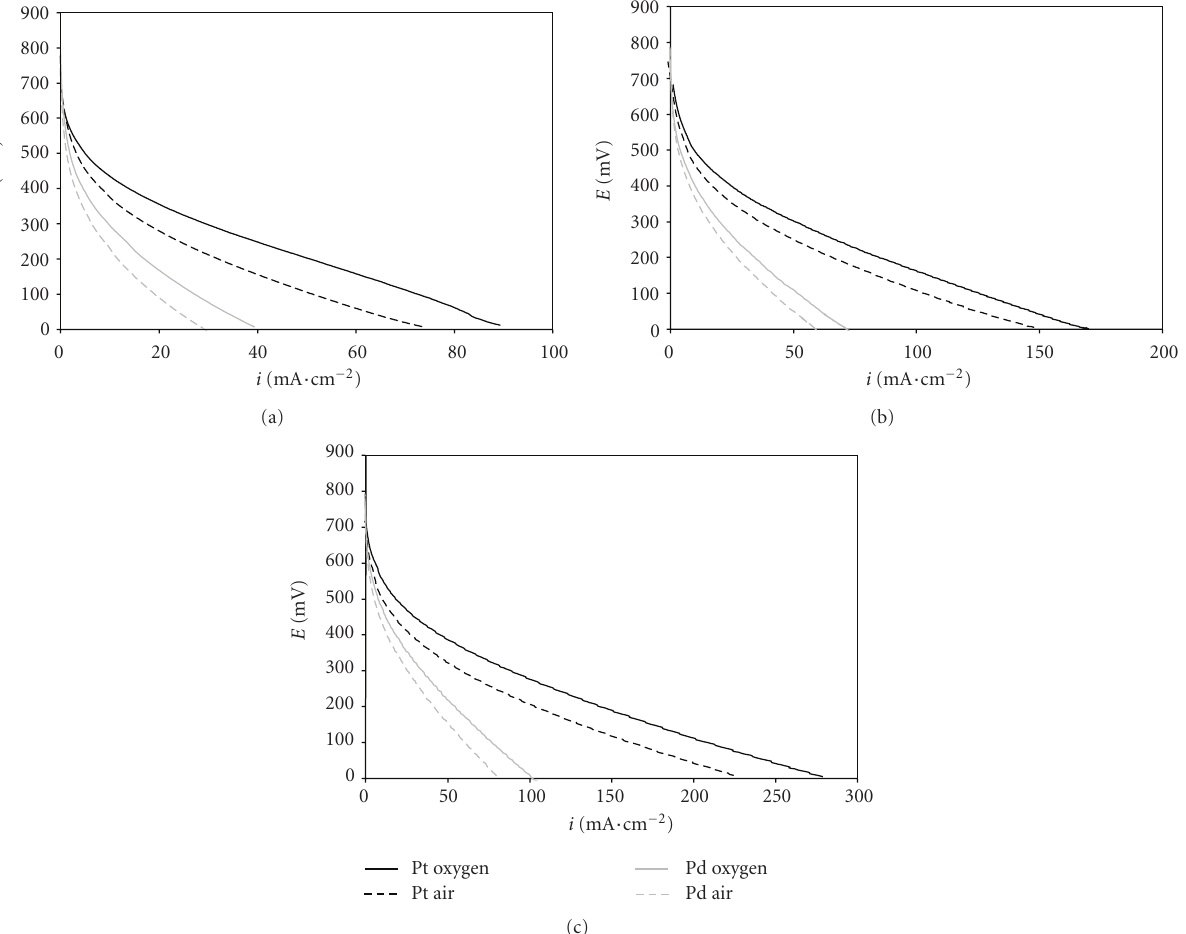
Figure 3: (a) Comparison of polarization curves of a direct methanol fuel cell with Pd/C and commercial Pt/C from E-tek as cathode catalyst at 20 ◦ C and 1 M methanol. (b) Comparison of polarization curves of a direct methanol fuel cell with Pd/C and commercial Pt/C from E-tek as cathode catalyst at 40 ◦ C and 1M methanol. (c) Comparison of polarization curves of a direct methanol fuel cell with Pd/C and commercial Pt/C from E-tek as cathode catalyst at 60 ◦ C and 1 M methanol.